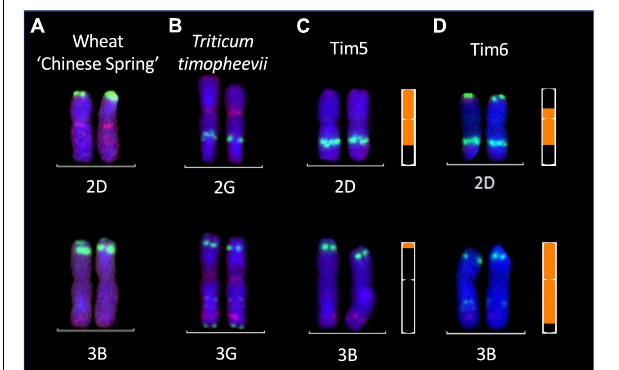
FIGURE 8 | Multi-color fluorescence in situ hybridization analysis of root metaphase spreads of 2D and 3B chromosomes from (A) wheat cv. Chinese Spring (B) chromosomes 2G and 3G of T. timopheevii and chromosomes 2D and 3B of FHB resistant wheat- T. timopheevii introgression lines (C) Tim 5 and (D) Tim6. Green and red signals show pSc119.2 and pAs.1 binding sites, respectively. KASP marker-derived ideograms of the introgressions in Tim 5 and Tim 6 are shown to the right. Size of introgressions from A t and G subgenomes is indicated in orange in a wheat chromosome shown in